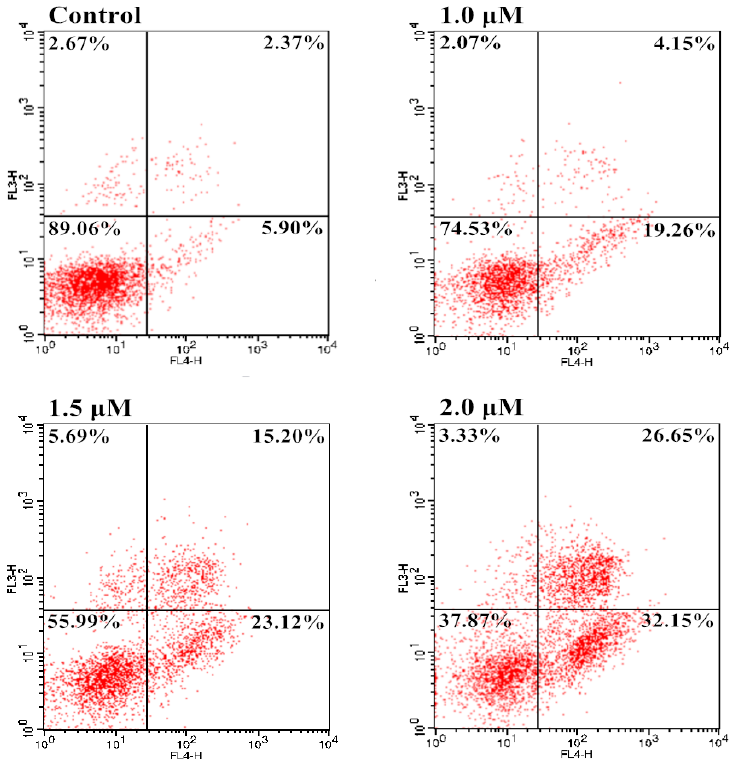
Figure 5. Apoptosis in Bel-7402 cells by treatment with 10f : Bel-7402 cells were incubated with different concentrations of 10f for 24 h and the cells were stained with annexin V-FITC and PI, followed by flow cytometry analysis.